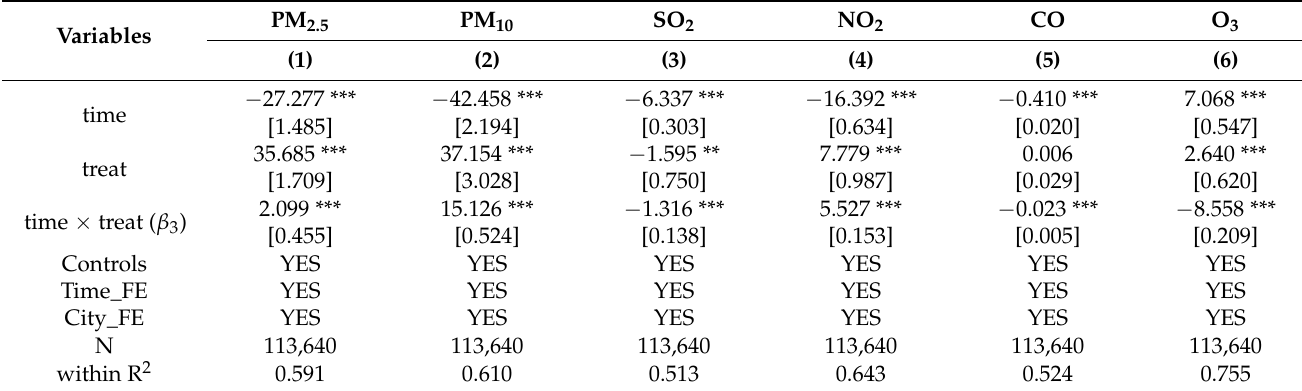
Table 5. Estimation results of the BSDW policy in heating